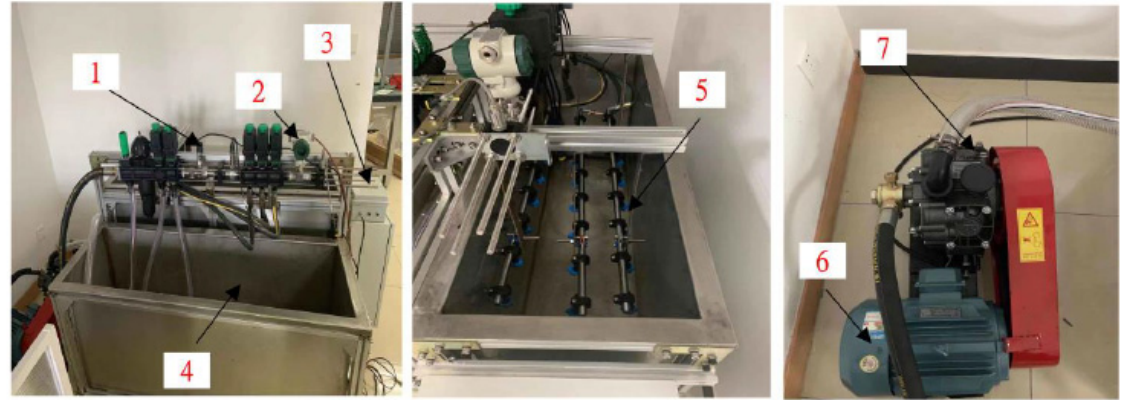
Figure 6. Spraying performance experimental platform: 1, pressure sensor; 2, flow sensor; 3, data acquisition unit; 4, tank; 5, nozzles; 6, motor; 7, diaphragm pump.